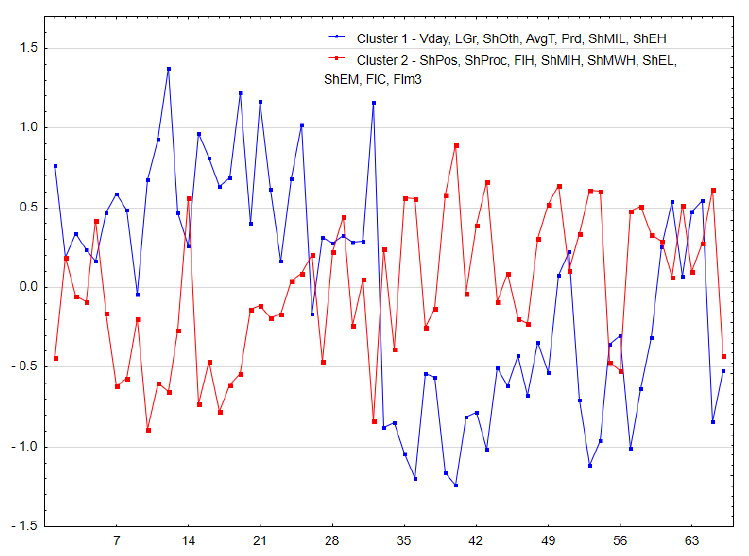
Figure 6. K-means separation of variables into clusters and their prevalence in consecutive workdays for machine B.